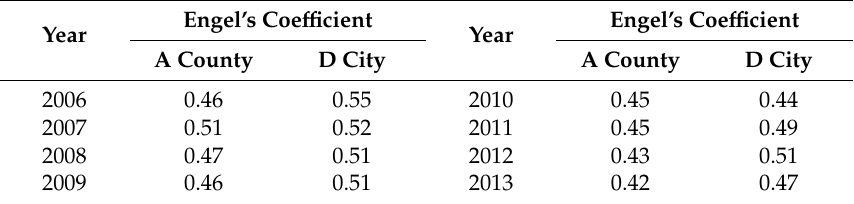
Table 1. Engel’s coe ffi cient of the all residential households in A county and D